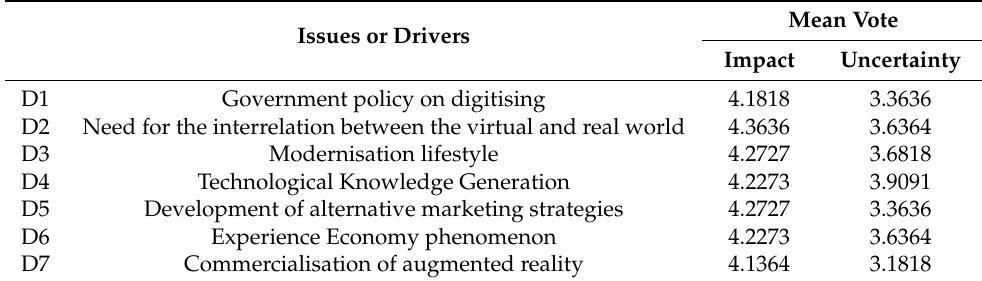
Table 3. Mean vote of impact and uncertainty for the top issues or